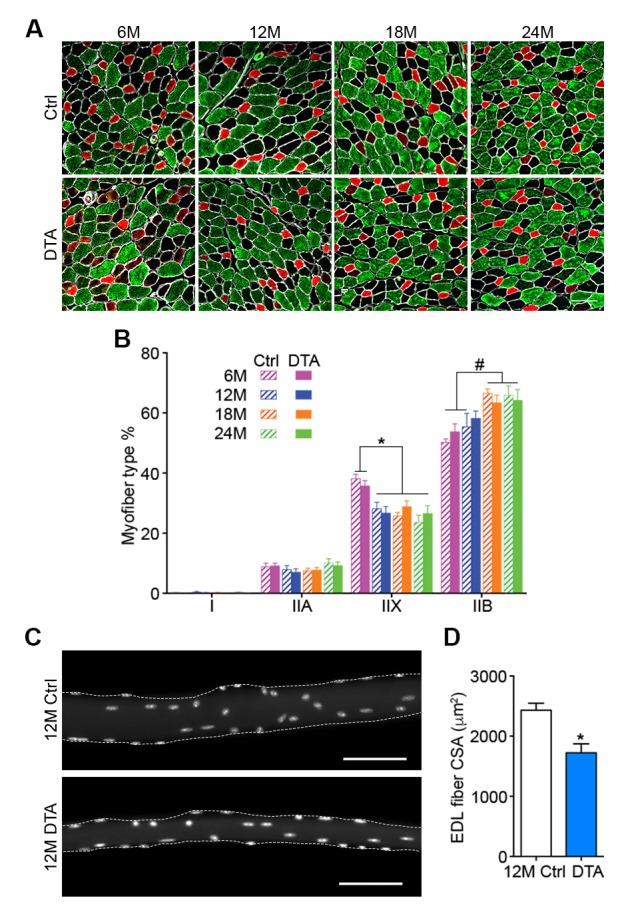
Age-related myofiber atrophy is observed in middle-aged P7DTA muscles.(A) Representative images of Ctrl and P7DTA TA/EDL muscles showing MyHC type IIA (red), IIB (green) and IIX (black) myofibers and Laminin IF stain (white). Scale bar = 100 μm. (B) Quantification of myofiber type composition in Ctrl and P7DTA TA/EDL muscles. *p<0.05, 6M Ctrl/P7DTA vs. 12M/18M/24M Ctrl/P7DTA; #p<0.05, 6M Ctrl/P7DTA, 12M Ctrl vs. 18M/24M Ctrl/P7DTA; two-way ANOVA/Sidak multiple comparison test. (C) Representative images of fixed 12-month-old Ctrl and P7DTA EDL single myofibers stained with DAPI; dashed lines show the outline of the myofiber segments. Scale bar = 100 μm. (D) Quantification of myofiber cross-sectional area (CSA) in fixed 12-month-old Ctrl and P7DTA EDL muscles. *p<0.05 compared to Ctrl, unpaired Student’s t-tests. n = 3 (24M Ctrl); 4 (6M P7DTA, 12M Ctrl, 12M P7DTA, 18M P7DTA, 24M P7DTA) or 5 (6M Ctrl, 18M Ctrl) mice (B); n = 4 muscles per group (D).